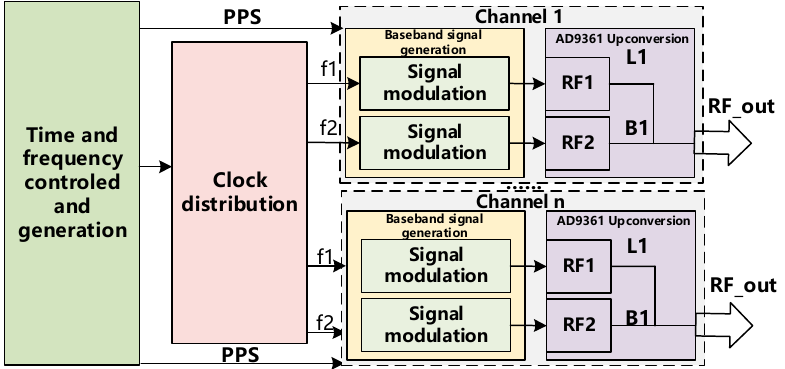
Figure 2. Transmission base station working principle.